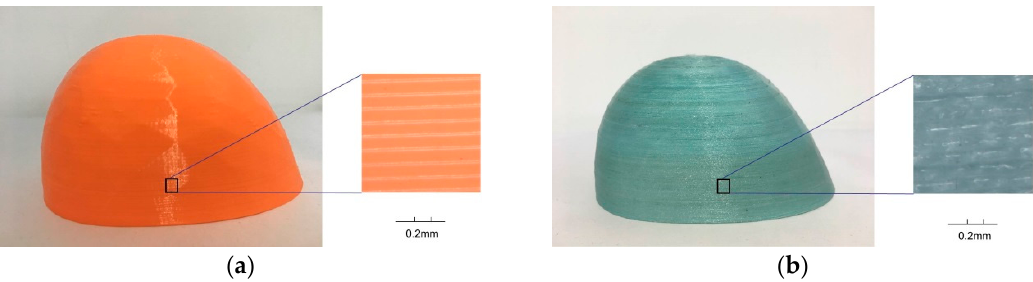
Figure 3. Surface of safety shoes cover. ( a ) Pure Polylactic Acid (PLA). ( b ) PET fiber-reinforced thermoplastic composites (PFRTPCs).